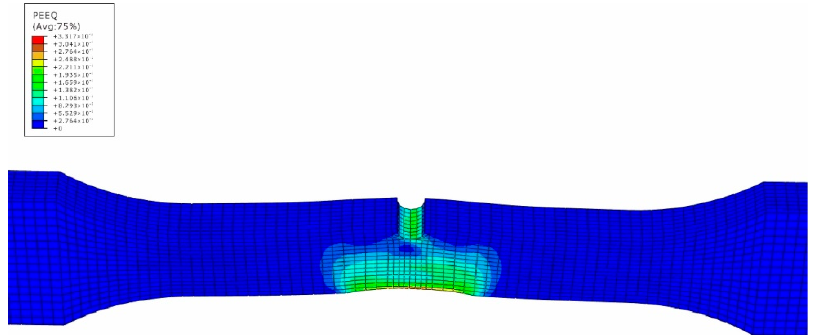
Figure 10. Strain field of back surface with precrack of dissimilar lightweight materials welded joint.